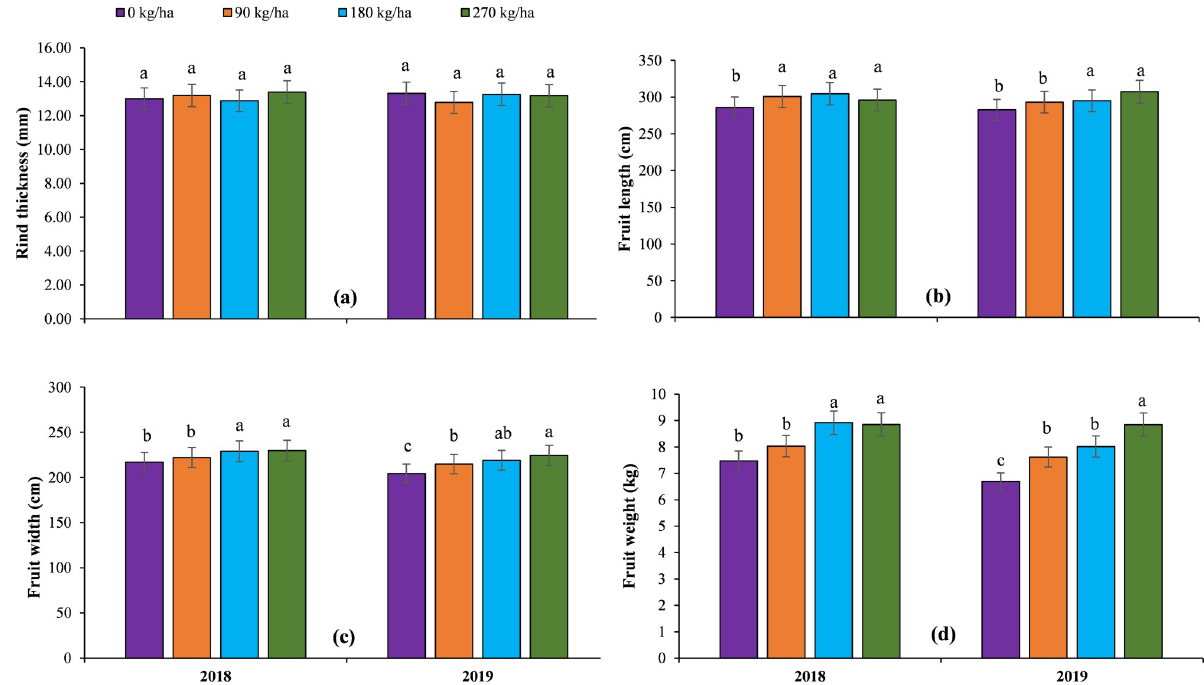
Fig 1. The impact of different nitrogen doses on growth attributes of grafted watermelon under field conditions.